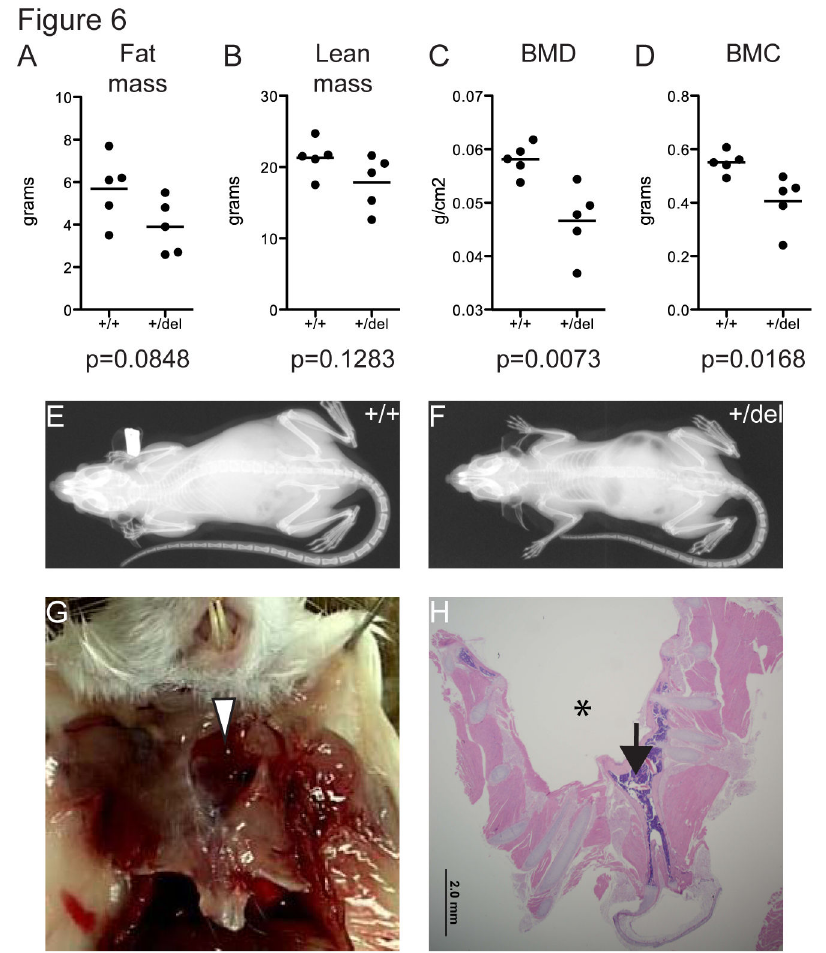
Figure 6. Body composition and skeletal phenotypes in adult Porcn +/del females. Adult Porcn +/del and Porcn +/+ females were subjected to X-ray imaging and body composition analysis. While fat mass (A) and lean mass (B) was not significantly different (t- test), bone mineral density (BMD, C) and bone mineral content (BMC, D) were significantly reduced in heterozygous females. X-ray imaging was unremarkable in both control (E) and heterozygous females (F). One out of the five analyzed heterozygous female exhibited a sternal gap (G, white arrowhead). Consistent with duplication of the sternal skeleton, osseous structures on either side were enveloped by periosteal tissue (H). Arrow indicates the border between left and right ribcage and the sternal gap is indicated by